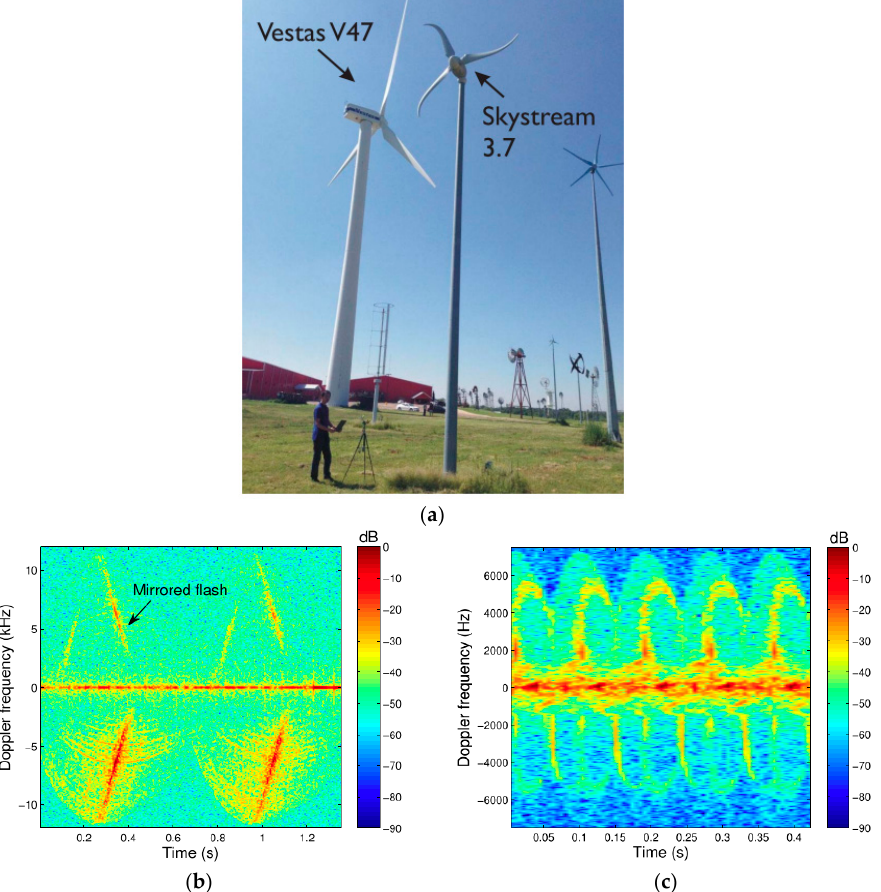
Figure 12. SHM of industrial wind turbines: ( a ) experimental scenario; ( b ) spectrogram for the Vestas V47 illuminated by a 24-GHz Doppler radar; ( c ) spectrogram for the Skystream 3.7 illuminated by a 24-GHz Doppler radar sensor. Reprinted with permission from ref. [28]. Copyright 2016